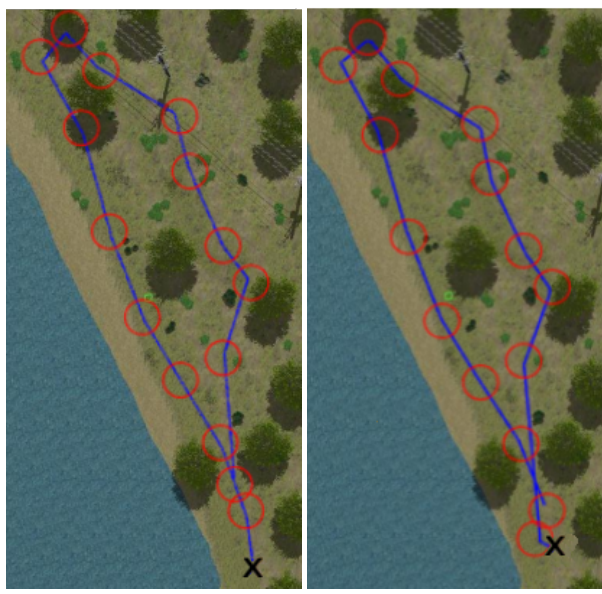
Figure 9. Paths followed during data acquisition in the lake